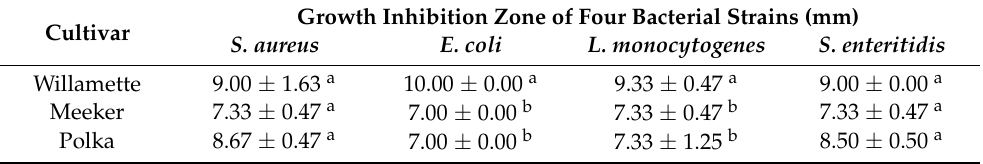
Table 6. Antimicrobial activity of the polyphenolic extracts of all the examined raspberry varieties, obtained using UAE under optimal